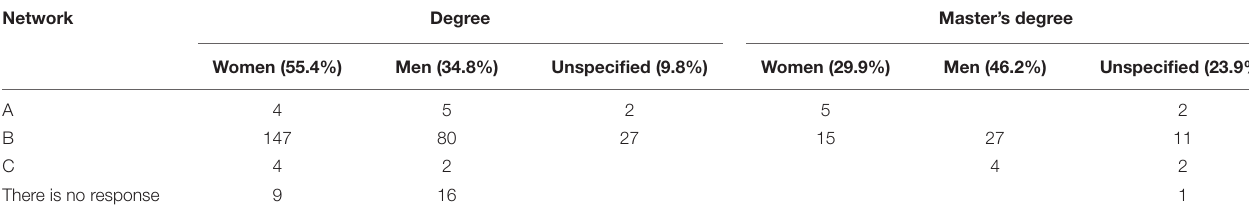
TABLE 3 | Responses to the activity 4.a.